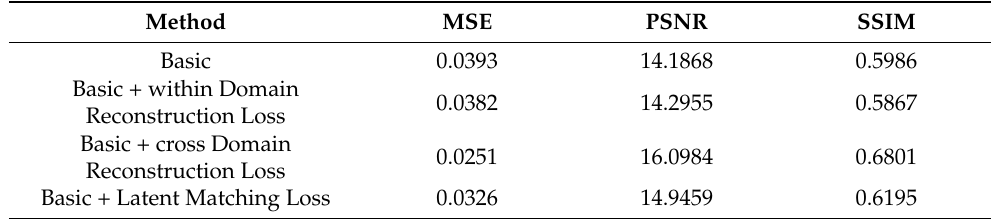
Table 6. Ablation study of the translation from infrared spectrum domain to visible spectrum